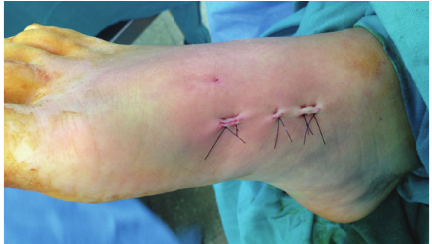
Figure 3: Clinical result after MIS Lisfranc bridge plating.